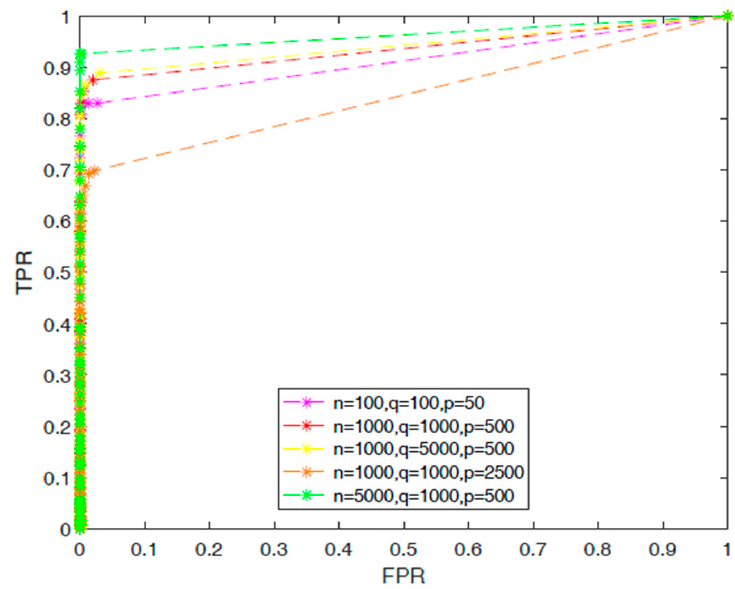
Figure 1. ROC curves of different parameters.